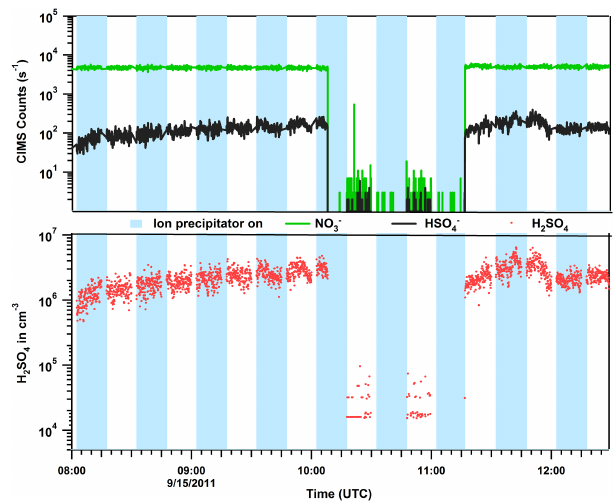
Figure 9. Daytime atmospheric [H 2 SO 4 ] measurements along with the setting of the ion precipitator. In the upper graph, the count rates of the primary ions NO − and the HSO − product ions are displayed 3 4 while the ion precipitator is enabled every 15min. While the corona ion source is on, the signal of both NO − and HSO − is not notice- 3 4 ably influenced by the ion precipitator. When the CIMS corona ion source is off, the maximum contribution of the ambient HSO − ions 4 can be evaluated to be several 10 4 moleculecm − 3